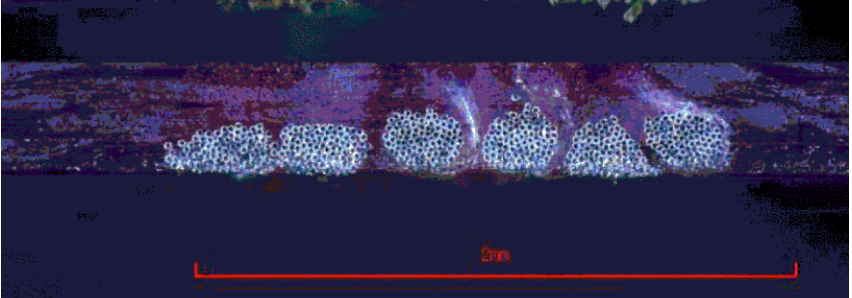
Figure 3. Smart composite made by embroidering transmission lines with conductive bobbin thread into twill woven S-glass pre-impregnated with epoxy resin then consolidating and curing [46]. In the figure, the embroidery thread (six cylinders) is composed of individual Kevlar fibers (navy dots) plated with silver (white). Reproduced with permission from Microwave Theory and